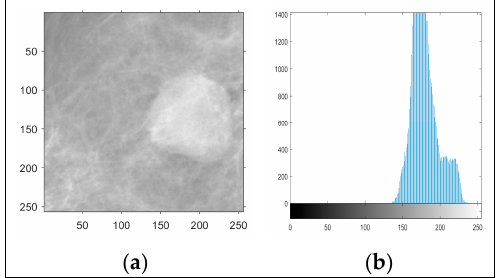
Figure 1. A mammography image ( a ) with its histogram profile ( b ).